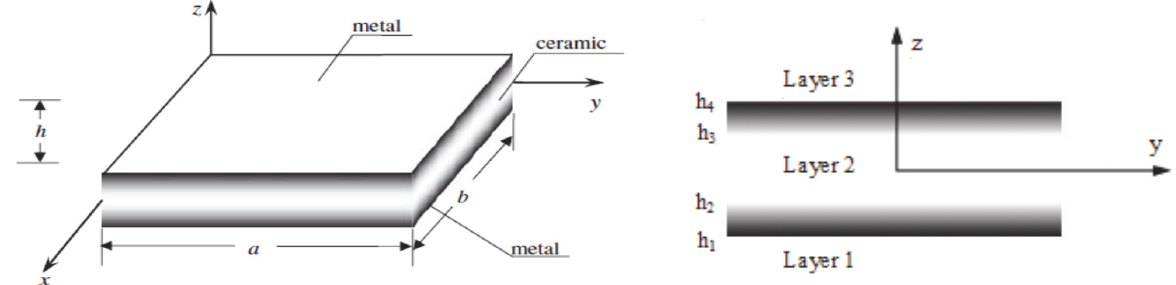
Figure 1: Geometry and coordinates of the porous sandwich plate